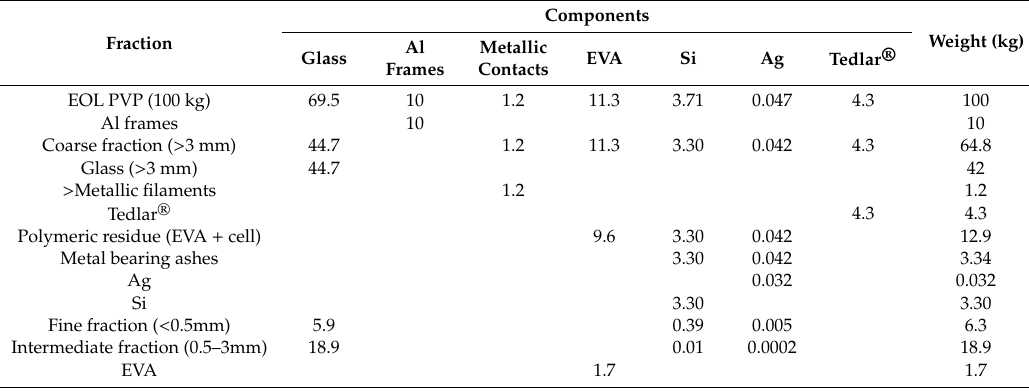
Table 4. Mass balance and fraction composition for the advanced PhotoLife